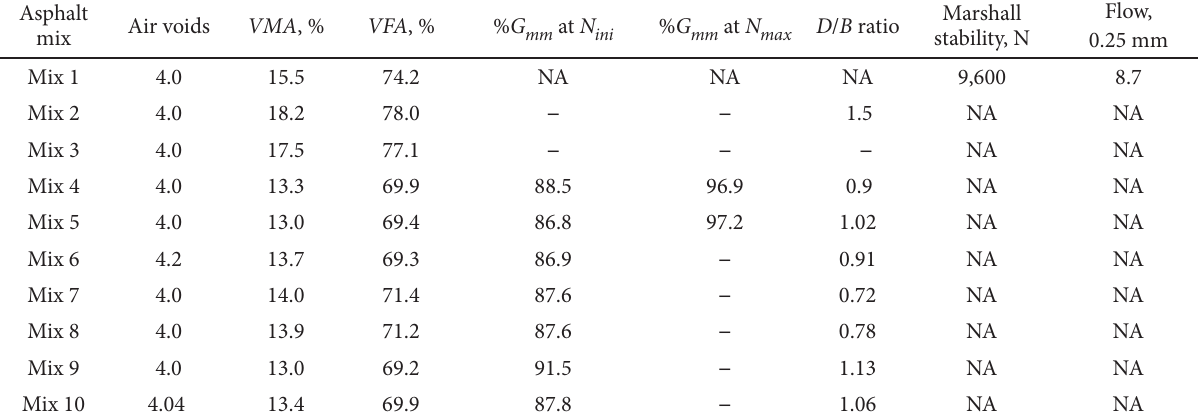
Table 3. Volumetric properties of different HMA mixes Asphalt